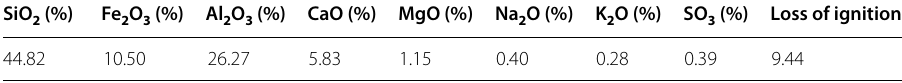
Table 3 Chemical composition of bottom ash SiO 2 (%)